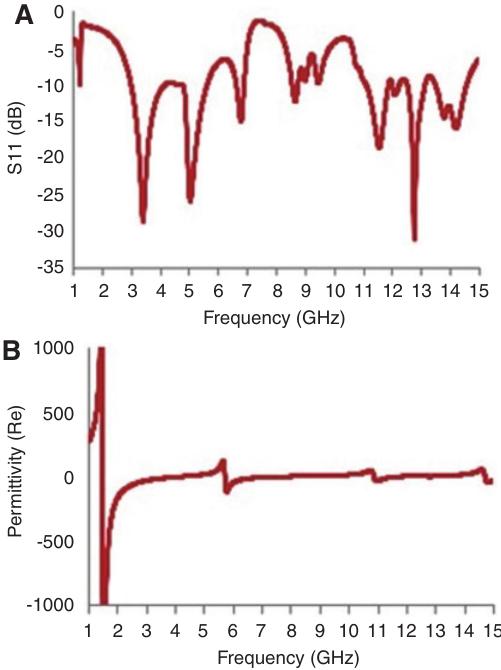
) in dB, (B) real Figure 3: (A) Real magnitude of permeability, (B) real magnitude of 11 refractive index.